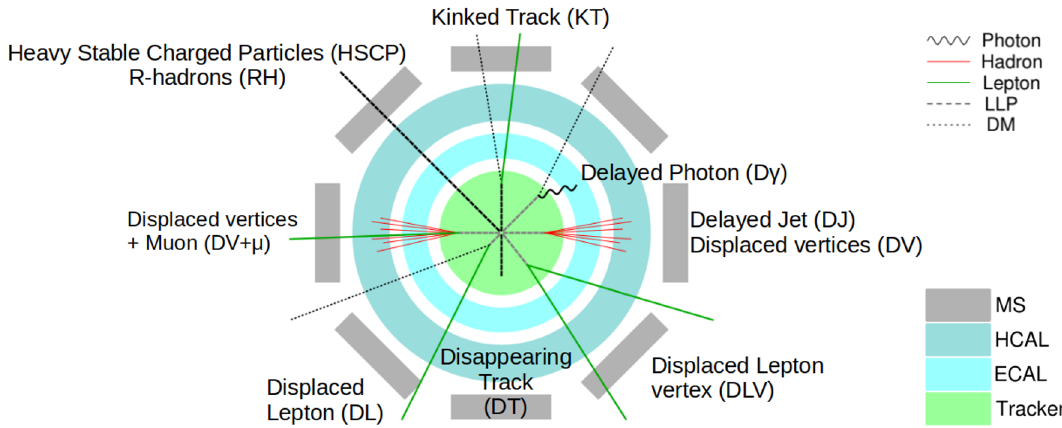
Figure 7. Schematic illustration of the LLP searches considered in table 2 and table 3 and described in appendix C. The green area represents the tracker, the blue (cyan) region denoted by HCAL (ECAL) refers to the hadronic (electromagnetic) calorimeter, the gray boxes represent the muon spectrometer (MS). Dotted lines refer to DM, dashed lines refer to the LLP and they are darker for searches that require a charged track associated to